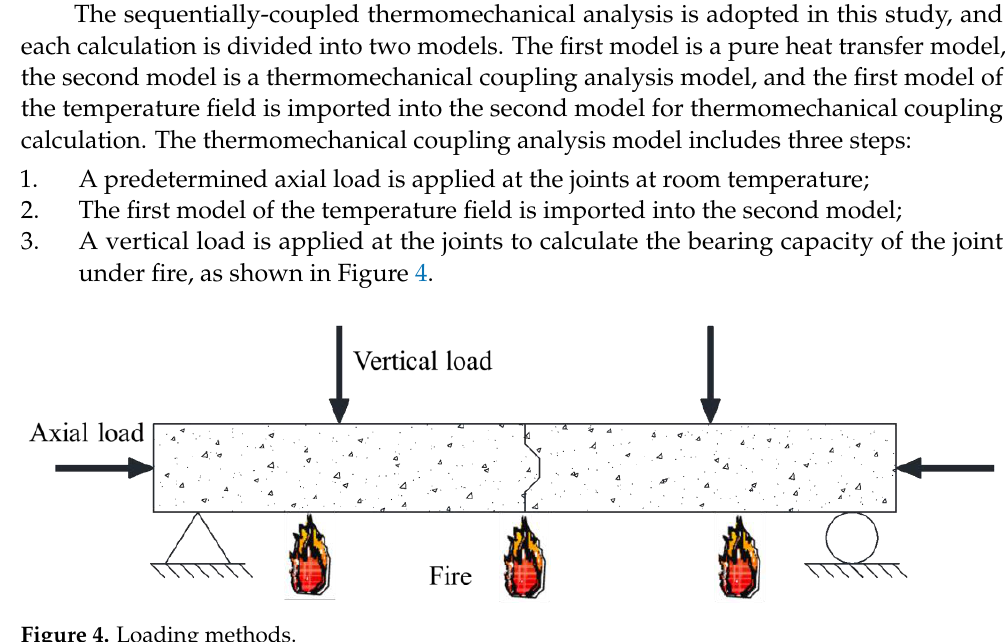
Figure 3. Model mesh (dimensions in mm).